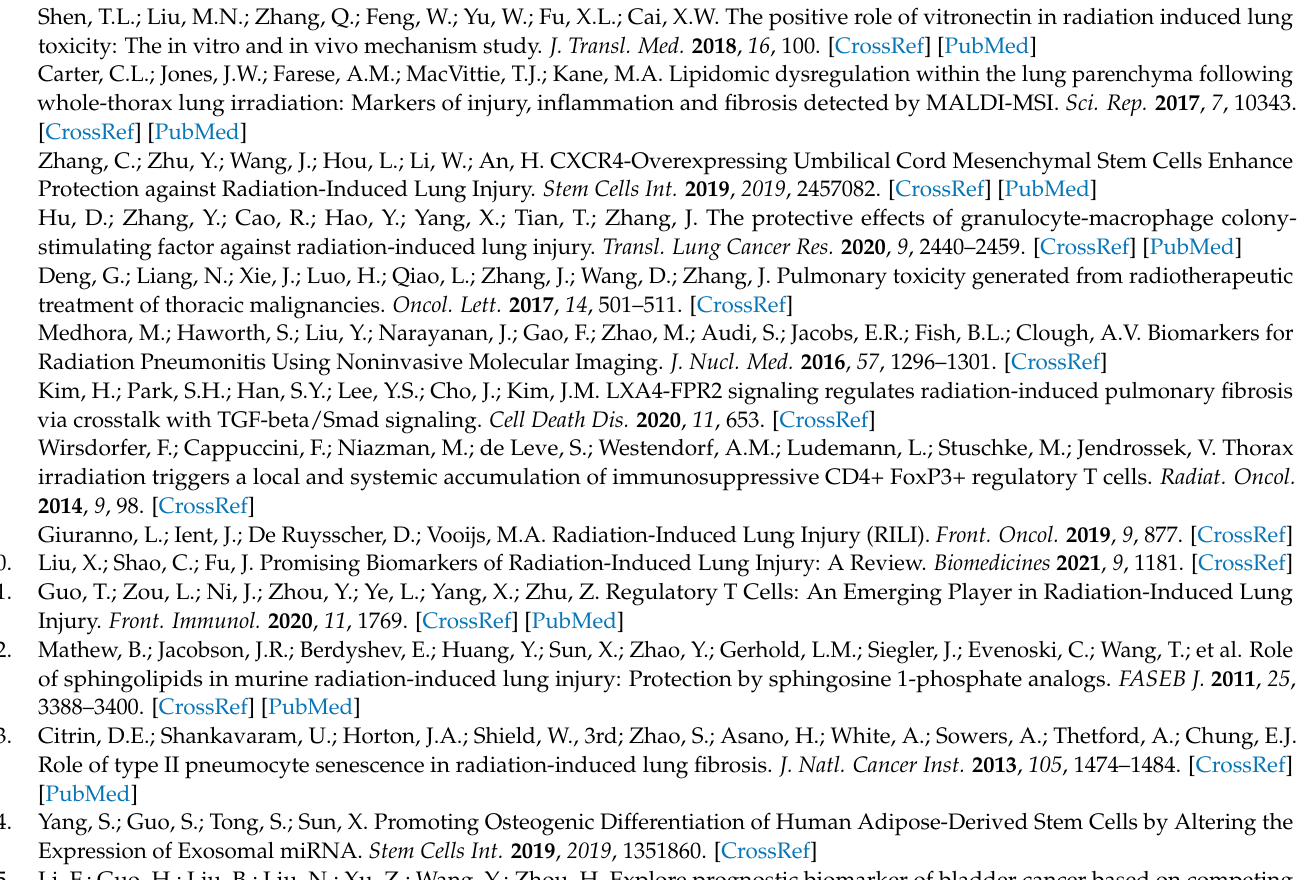
Table S2: Results of GO functional annotation analyses; Table S3: Results of KEGG signaling pathway analyses; Table S4: Differentially expressed genes related to